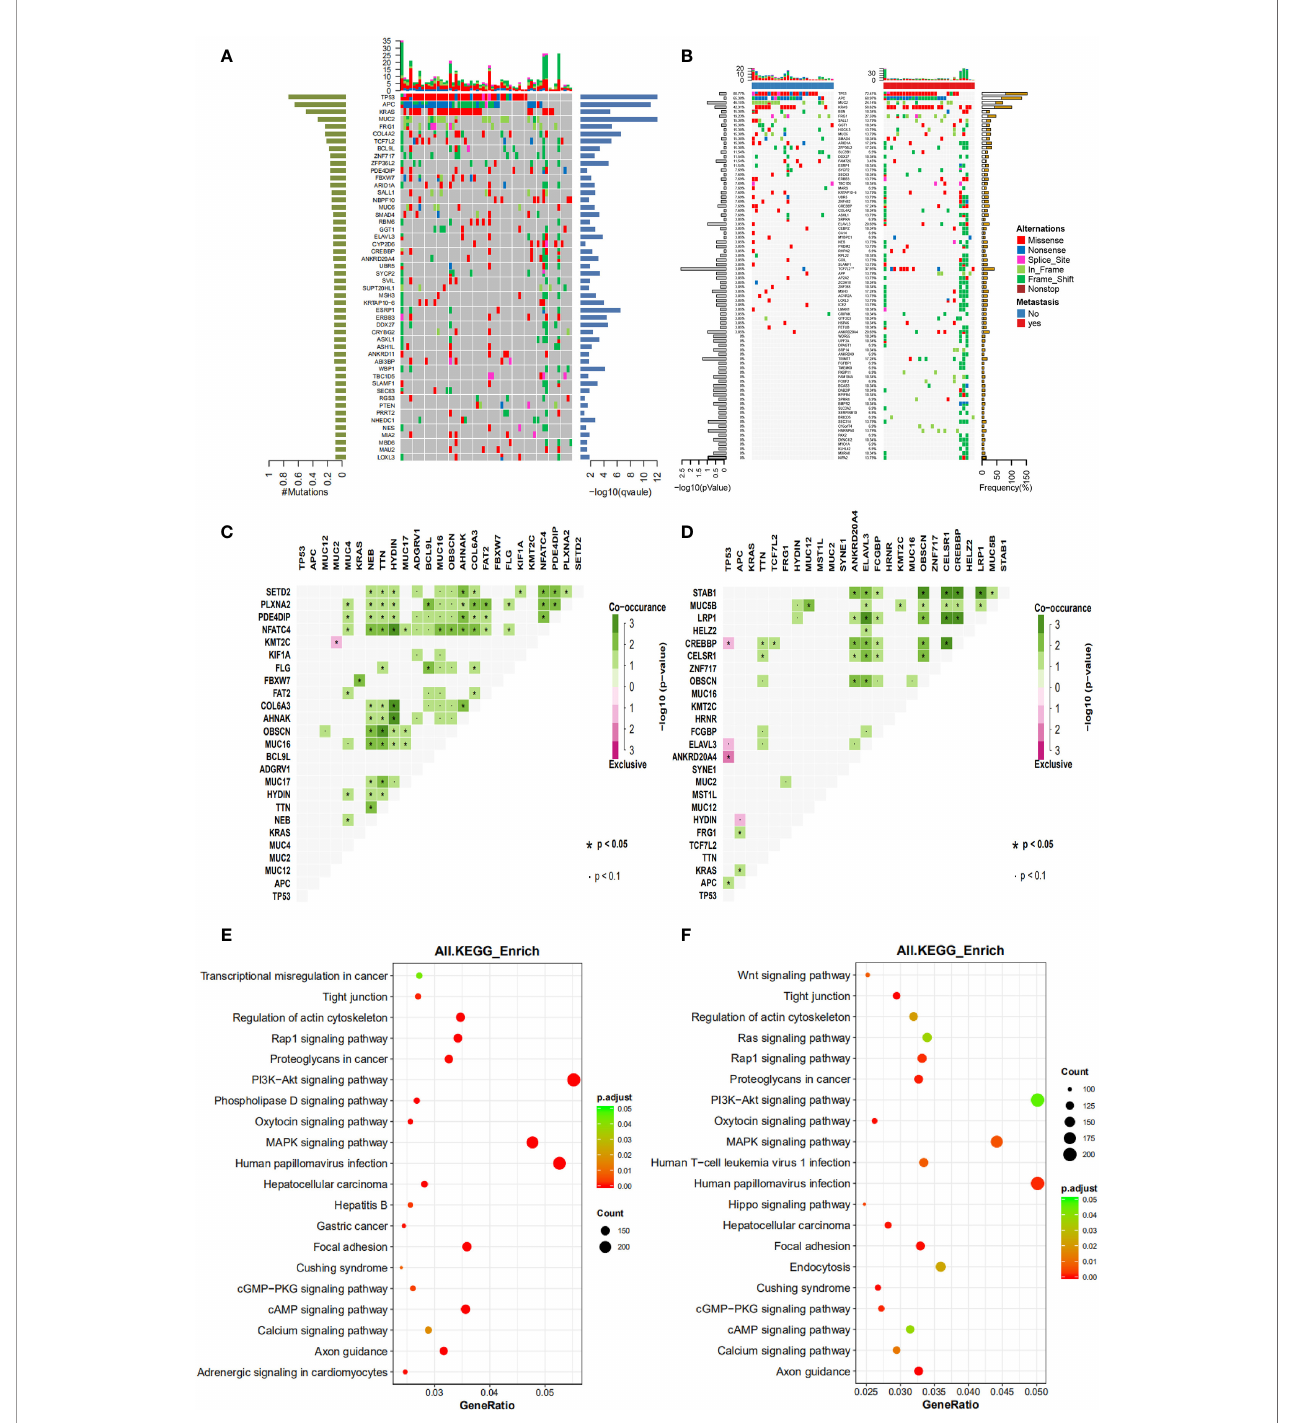
FIGURE 1 | The mutational spectrum, co-mutations, exclusive mutations and pathway analysis of CRC patients with or without liver metastases. (A) the mutational spectrum of all patients involved in this study, ranked by mutational frequency. (B) the mutational spectrum of patients without liver metastases (left panel) or patients with liver metastases (right panel). (C) the signi fi cant co-mutations and exclusive mutations of patients without liver metastases. (D) the signi fi cant co-mutations and exclusive mutations of patients with liver metastases. (E) the KEGG pathway enrichment analysis of patients without liver metastases. (F) the KEGG pathway enrichment analysis of patients with liver